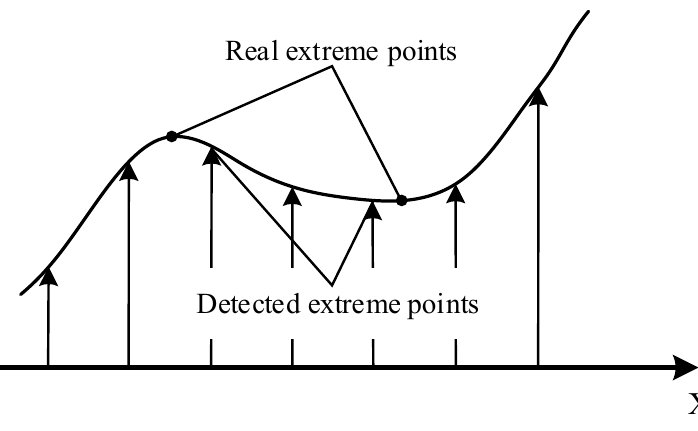
Figure 9. Difference between discrete space and continuous space.